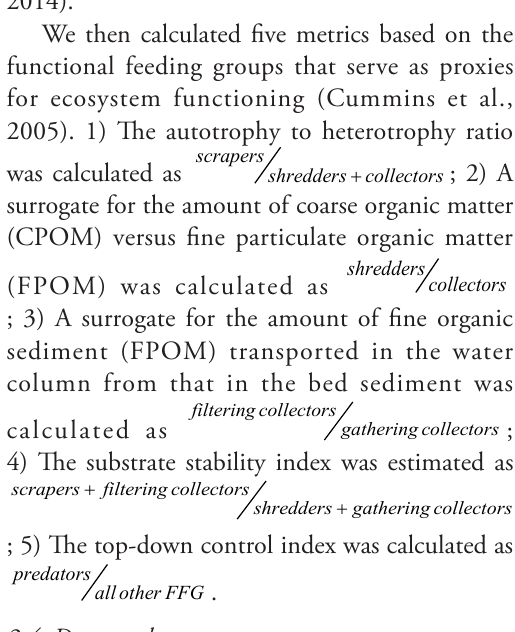
Figure 6. Post-hoc Tukey HSD test results of Turbidity (NTU) in the water column between riparian zone width categories. Table 2. Functional Feeding Groups (FFG) metrics. Stream